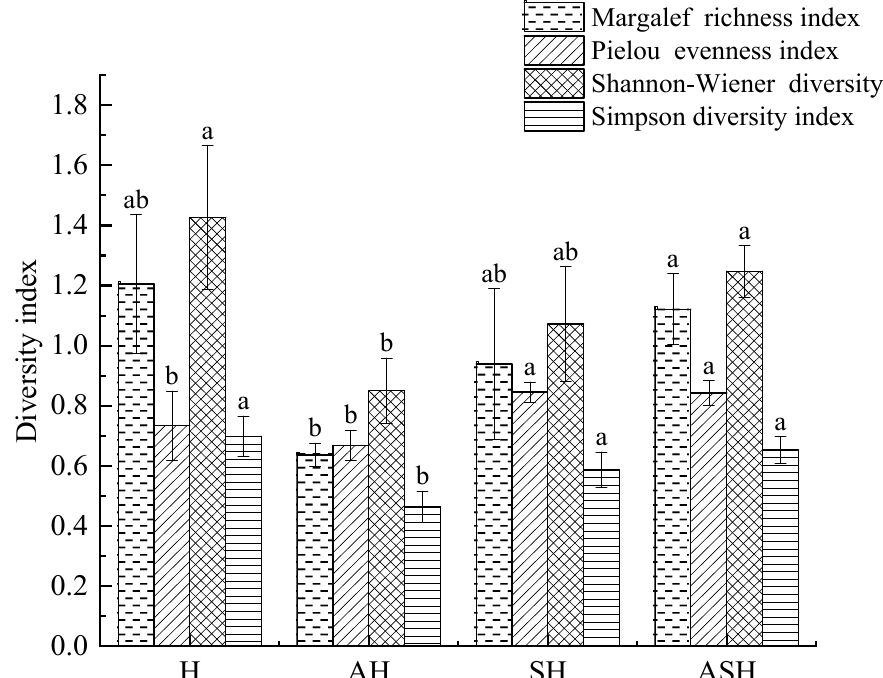
Figure 2. Species diversity index of plant community structure types. Different lowercase letters indicate significant differences of diversity index in different plant community structure types ( p < 0.05).